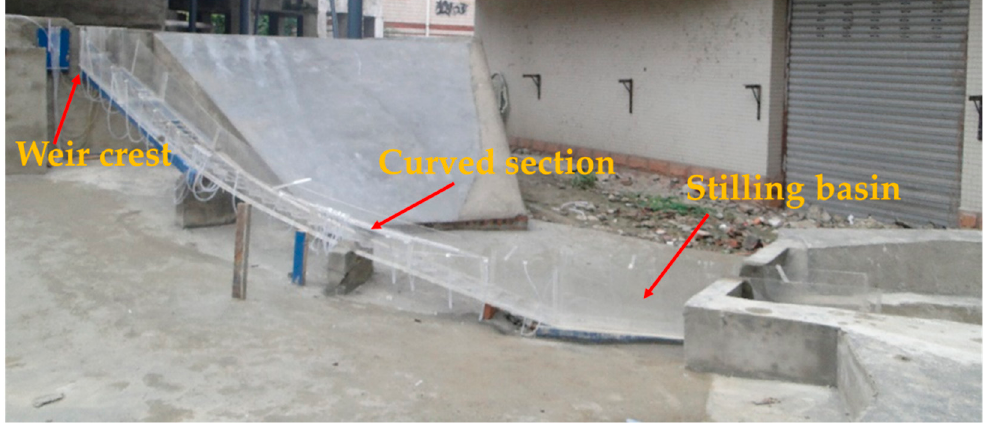
Figure 2. Schematic of step No. 9 with non-uniform heights at the bottom.